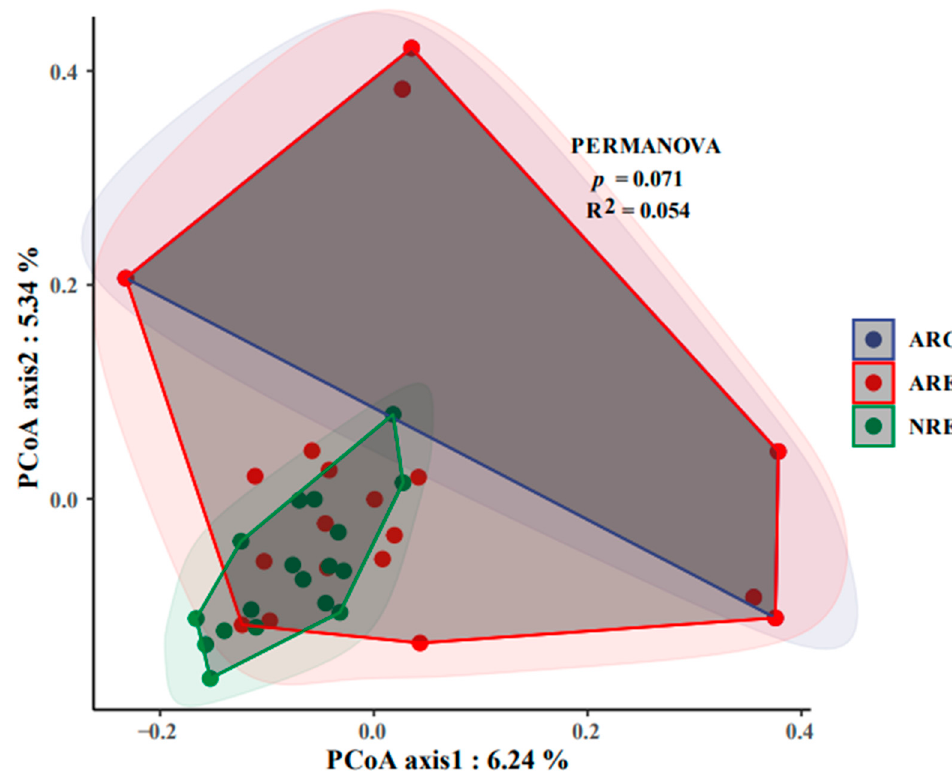
Figure 2. Beta diversity of natural water sources (NRE, included rw1-18 in blue) microbial community, artificial recharged water from earthen pond substrate (ARE, included rh1-19 in red) microbial community, and artificial recharged water from concrete pond substrate (ARC, included rc1-6 in green) microbial community.